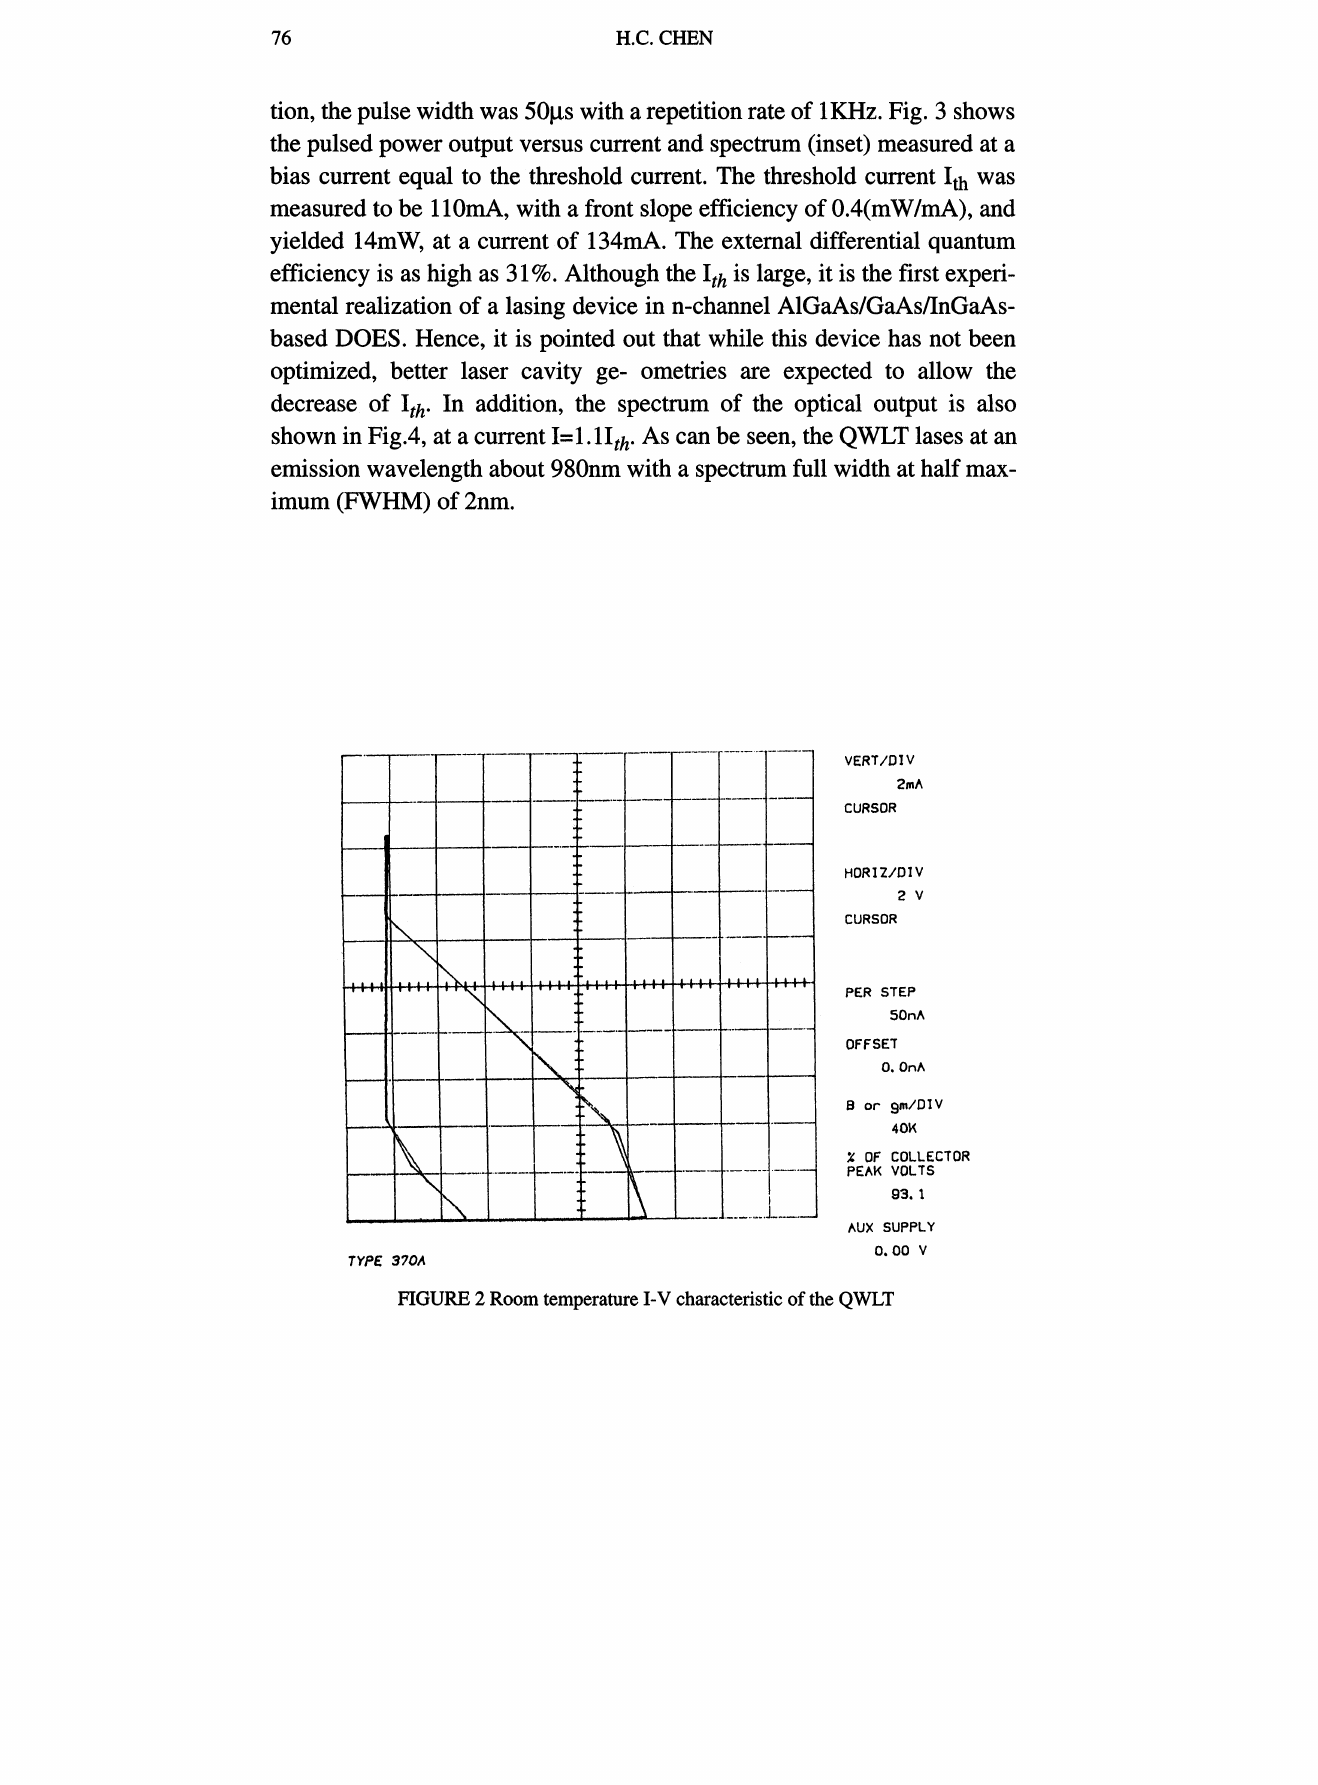
FIGURE 2 Room temperature I-V characteristic of the